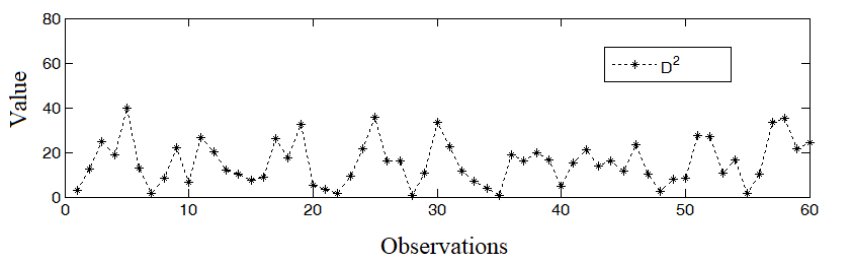
Figure 4. Vector of Mahalanobis distance between X and ( C , S C ) of C .